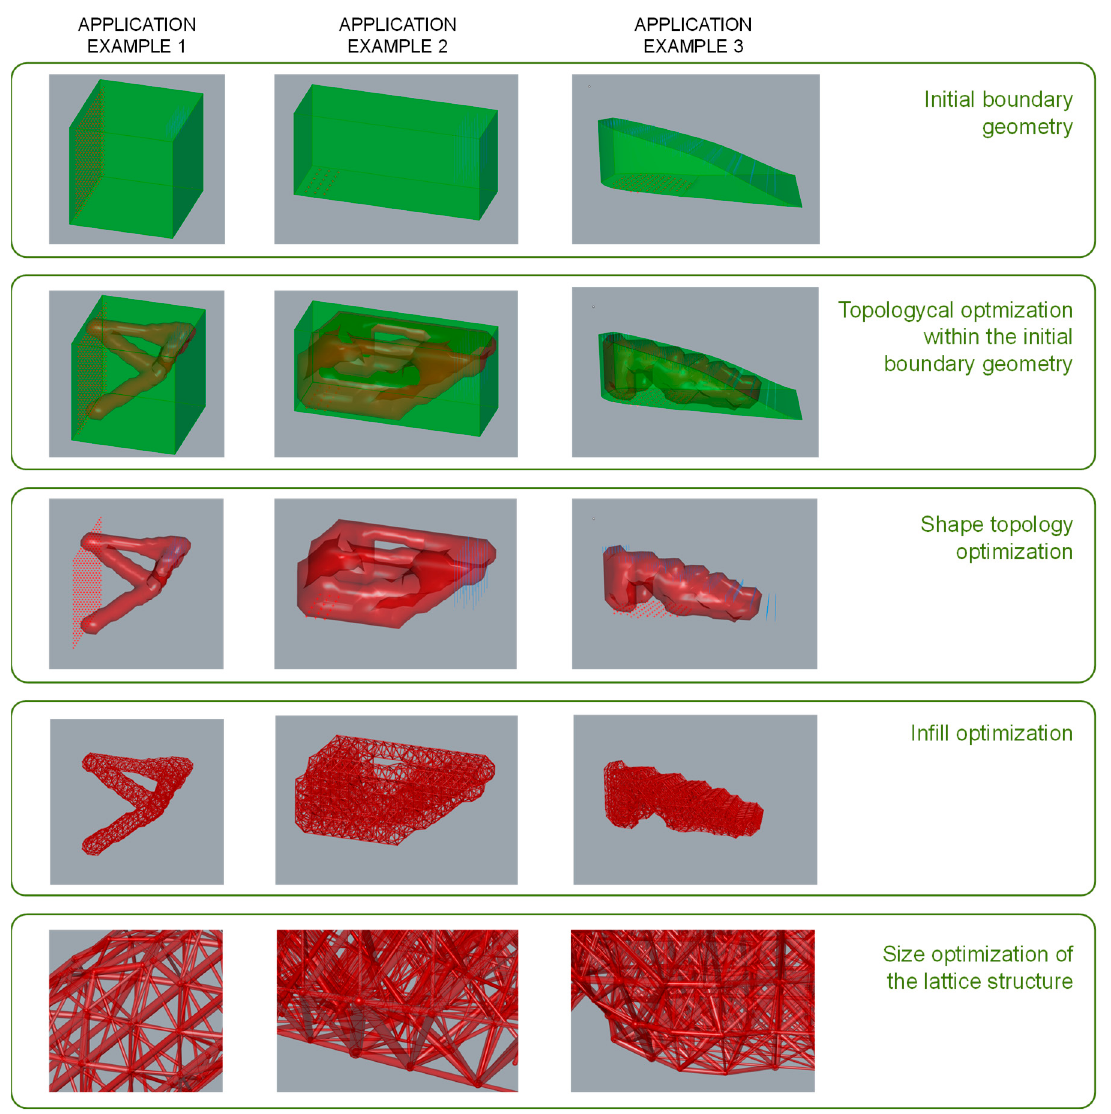
Figure 21. Methodology application examples.